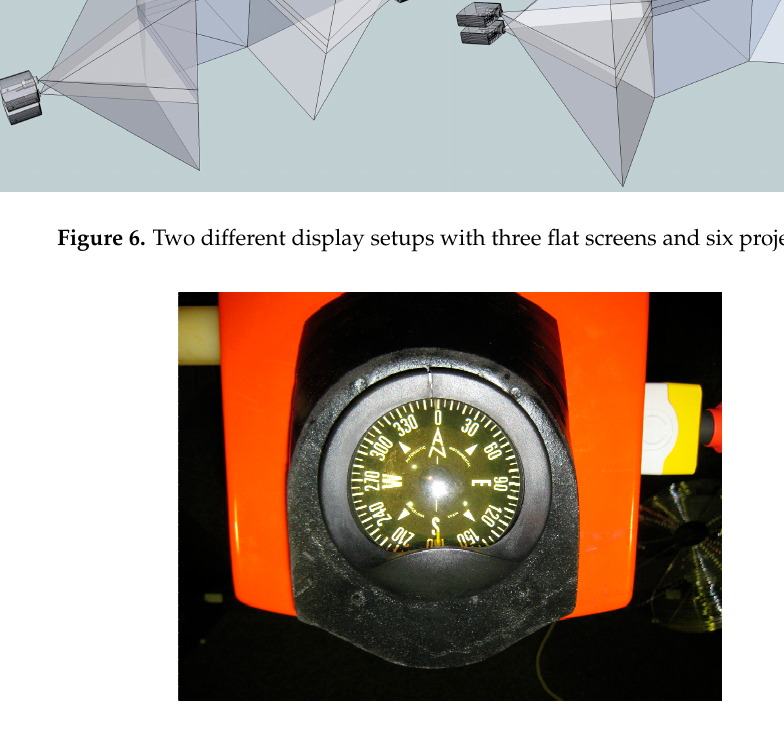
Figure 7. A motorized heading compass.